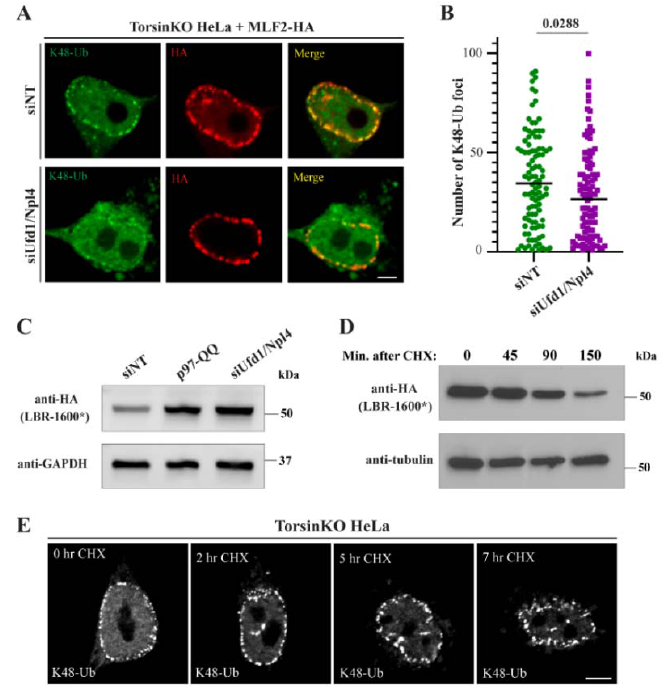
Figure 2. The K48-Ub proteins sequestered inside blebs do not result from canonical ERAD. ( A ) Rep- Figure 2. The K48 ‐ Ub proteins sequestered inside blebs do not result from canonical ERAD. ( A ) resentative IF images of TorsinKO cells overexpressing MLF2-HA under nontargeting (siNT) or Representative IF images of TorsinKO cells overexpressing MLF2 ‐ HA under nontargeting (siNT) or Ufd1/Npl4 knockdown conditions. Cells were treated with 25 nM RNAi against both Ufd1 and Npl4 for 48 h before processing for IF. Cells were stained with antibodies against K48-Ub and HA. Scale bar, 5 µ m. ( B ) The number of NE-associated K48-Ub foci in TorsinKO cells under nontargeting